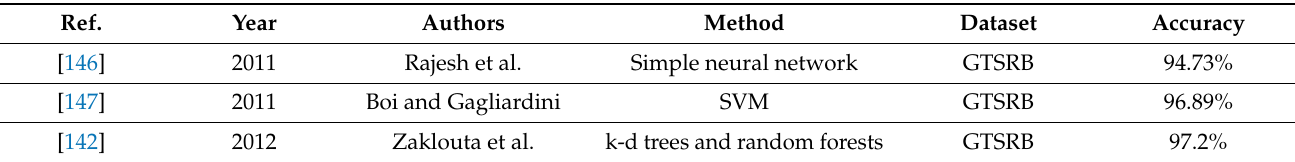
Table 3. Traffic Sign Recognition Studies with Traditional ML